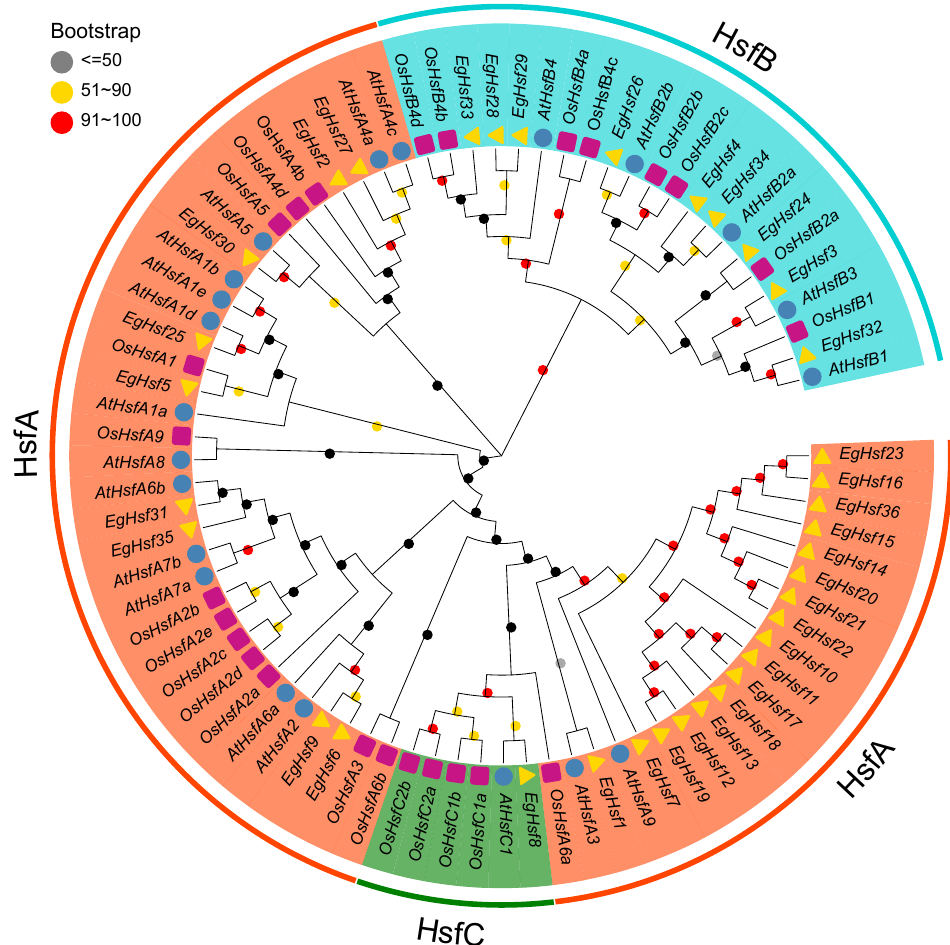
Figure 1. Phylogenetic analysis of full-length HSF protein sequences from E. grandis (Eg), A. thaliana (At) and Oryza sativa (Os). The number on the branch denotes the reliability of the node based on 1000 iterations of Bootstrap verification; branches of different classes have altered colors, each standing for a different